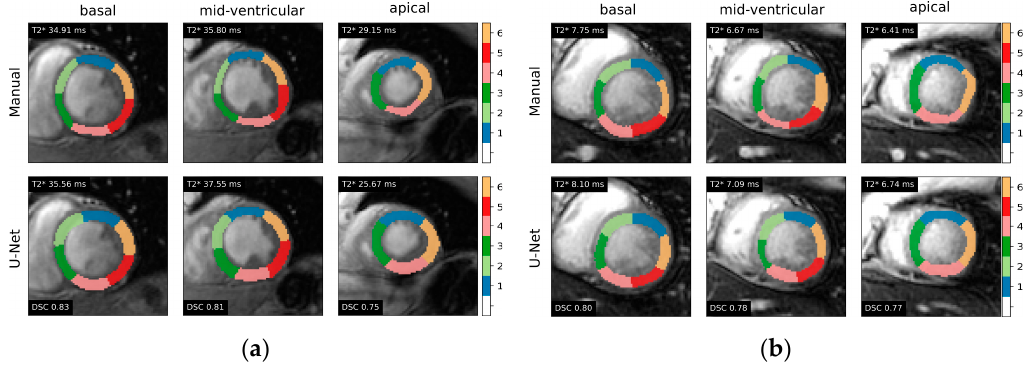
Figure 2. Representative examples of 16-segment AHA model myocardial segmentation from gradient-echo multi-echo T2* images in two testing cases: ( a ) subject with normal T2* values and ( b ) patient with iron overload. Ground-truth label masks (upper panels) and U-Net-based segmentations (lower panels) are shown for each of the three myocardial slices. Global T2* derived from the segmentation and Dice similarity coefficients (DSC) are also indicated.